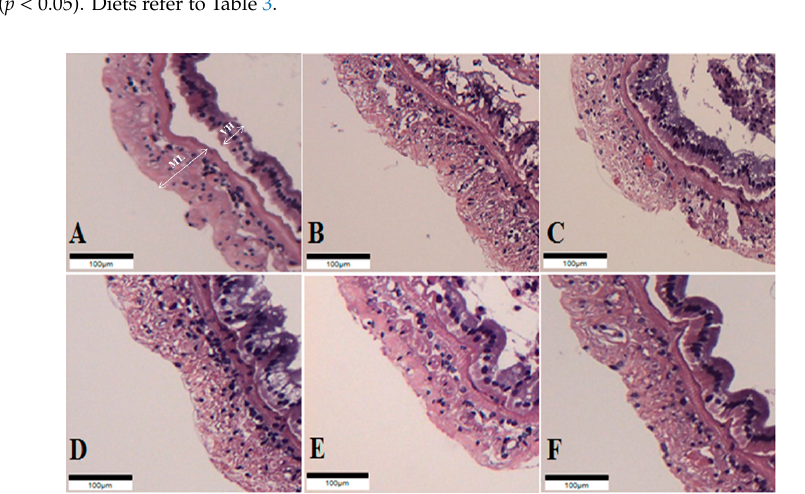
Figure 1. Histological sections of juvenile whiteleg shrimp intestine fed the experimental diets for 8 weeks. A-CON, basal diet; B-BS 7 , Bacillus subtilis at 1 × 10 7 CFU/g; C-BS 8 , Bacillus subtilis at 1 × 10 8 CFU/g; D-PP 8 , Pediococcus pentosaceus at 1 × 10 8 CFU/g; E-LL 7 , Lactococcus lactis at 1 × 10 8 CFU/g; F-OTC, oxytetracycline at 4 g/kg. (Scale bar = 100 µm; Original magnification × 4). ML = muscular layer thickness VH = villi height.